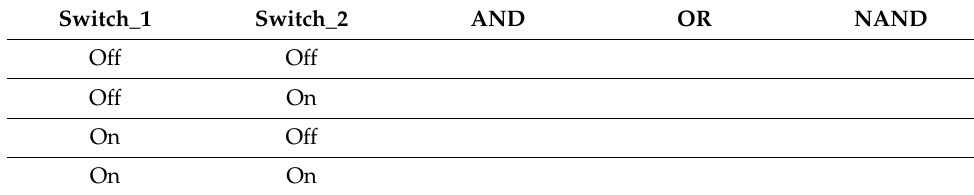
Table 1. The truth table for basic logic gates.